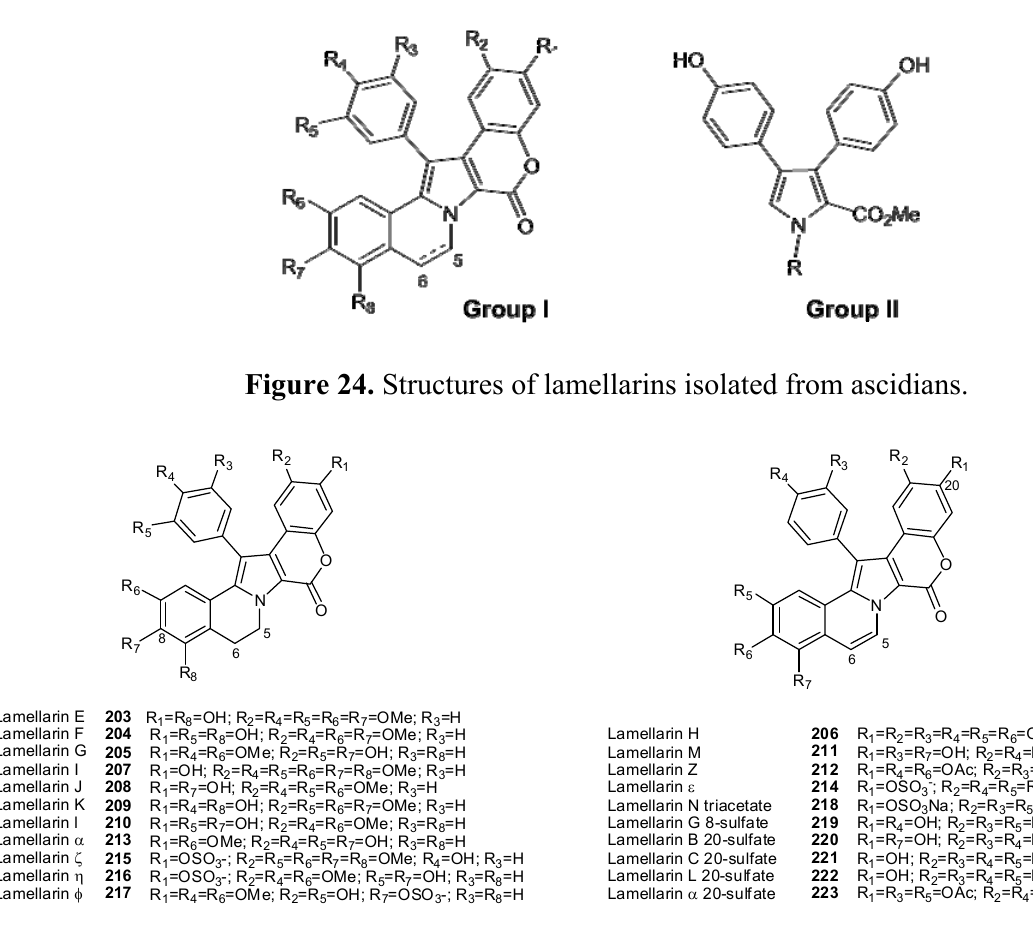
Figure 23. Core structures of lamellarins.